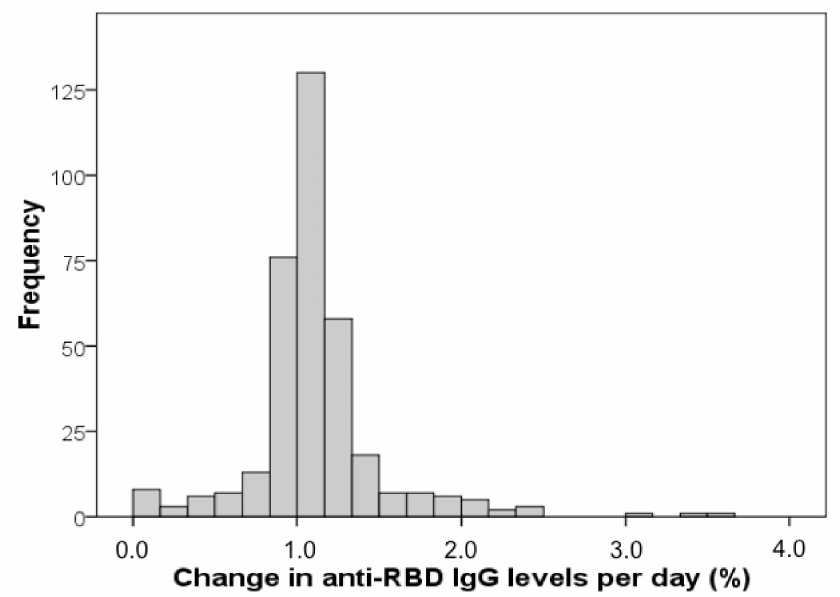
Figure 6. Distribution shown by histogram of the change (%) per day of anti S-RBD IgG levels. X axis represents % change in anti S-RBD IG levels per day, while y axis represents the absolute frequency of